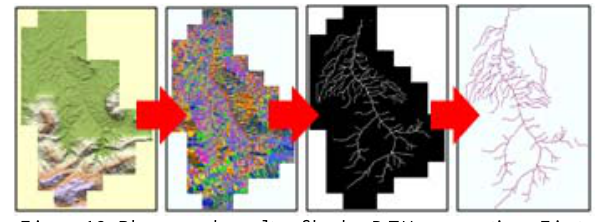
Figure 13. Phases and results of hydro-DTM generation. First hydrological generated DTM, next the flow direction raster model, next the least-cost path stream from river headers and finally the derivate stream extraction.